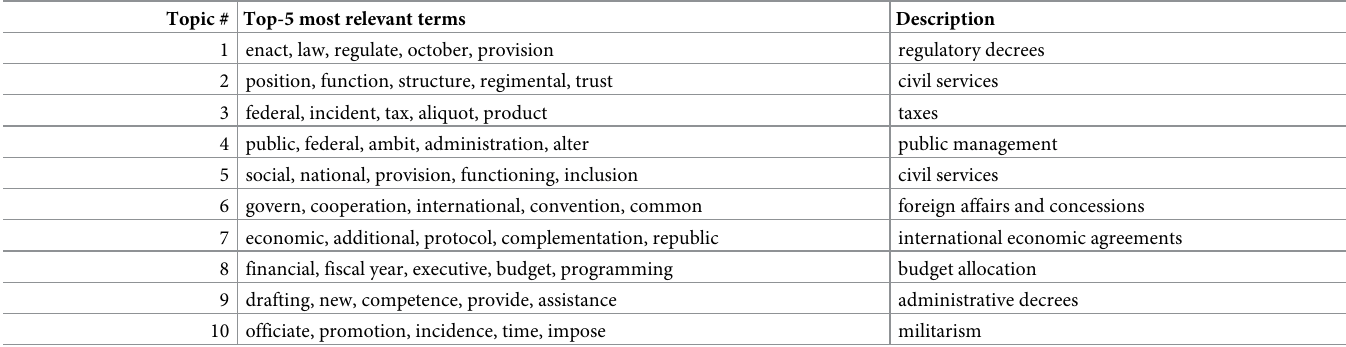
Table 2. Top 5 LDAvis terms for abstract analysis using λ =